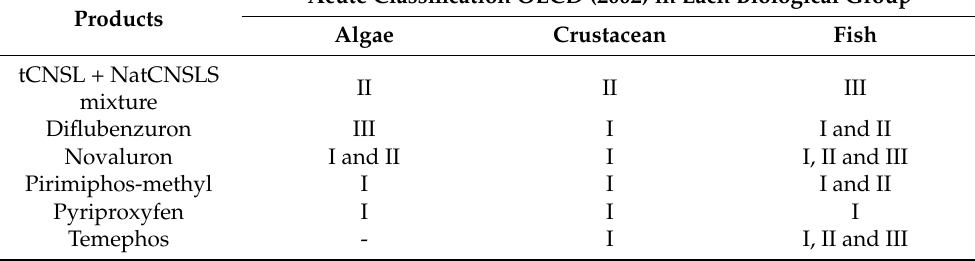
Table 2. Acute ecotoxicological classification (OECD, 2002) comparison of the tCNSL + NatCNSLS mixture with the larvicides recommended by WHO. Acute Classification OECD (2002) in Each Biological Group Products Algae Crustacean Fish tCNSL + NatCNSLS II II III mixture Diflubenzuron III I I and II Novaluron I and II I I, II and III